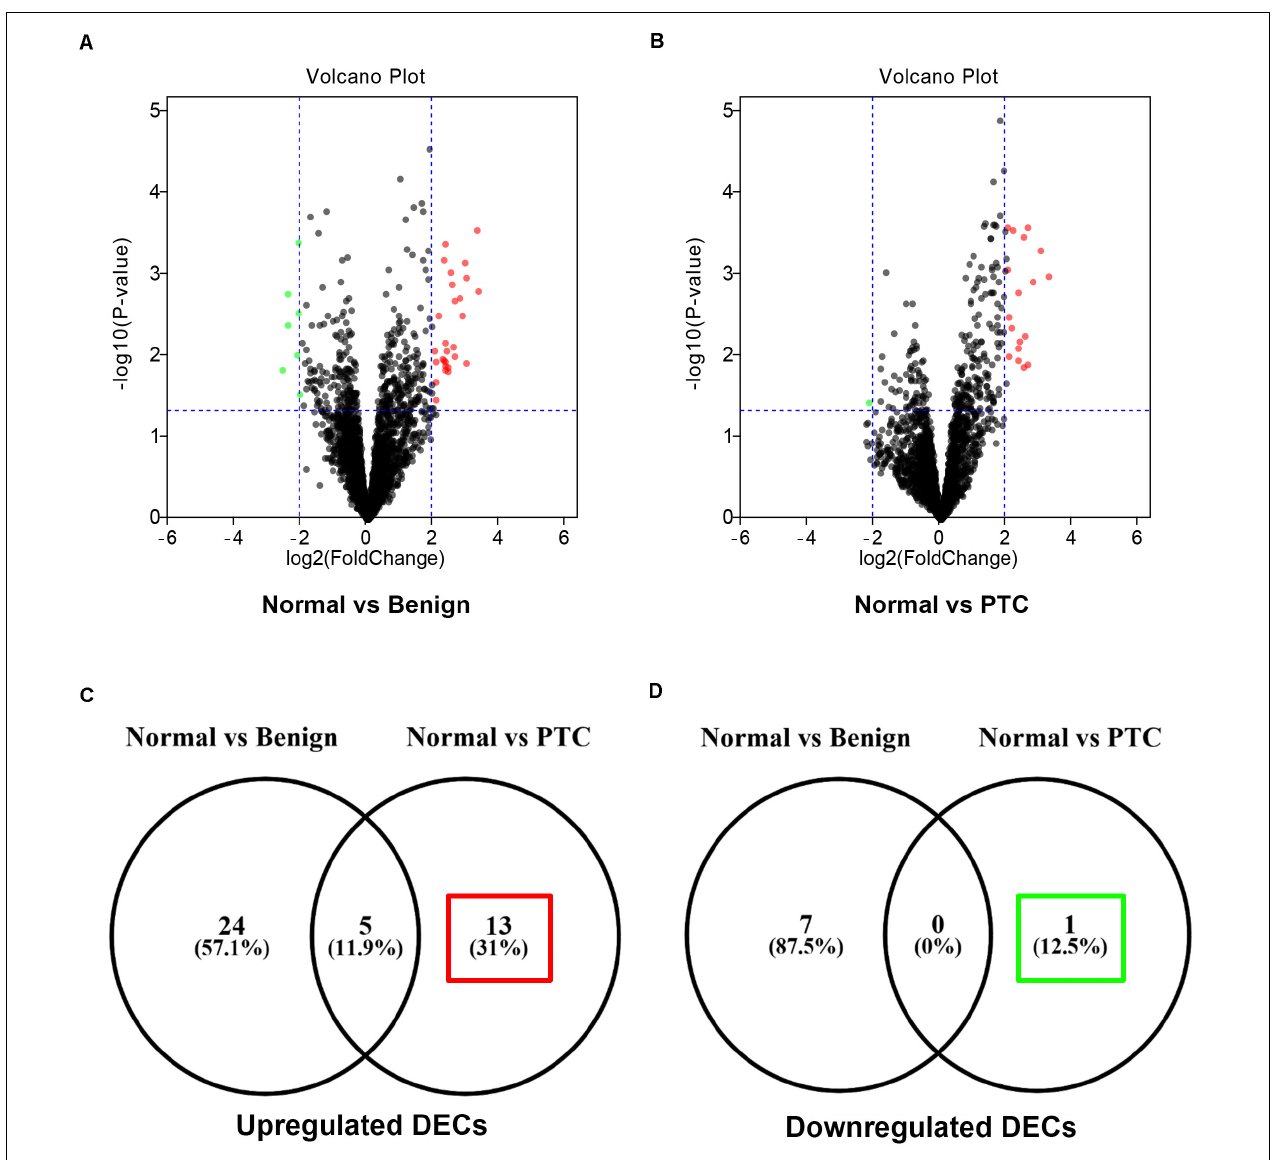
FIGURE 1 | Identification of candidate circRNAs associated with progression of papillary thyroid carcinoma (PTC). (A) The volcano plot of differentially expressed circRNAs (DECs) between 6 benign thyroid lesions and 6 normal thyroid tissues. (B) The volcano plot of differentially expressed circRNAs (DECs) between 6 PTC and 6 normal thyroid tissues. The red dots and green dots respectively represent upregulated DECs and downregulated DECs with significance ( P < 0.05 and |log 2 FC| > 1). The black dots are those DECs without significance. (C) The interaction analysis for upregulated DECs in both compared groups. (D) The interaction analysis for downregulated DECs in both compared